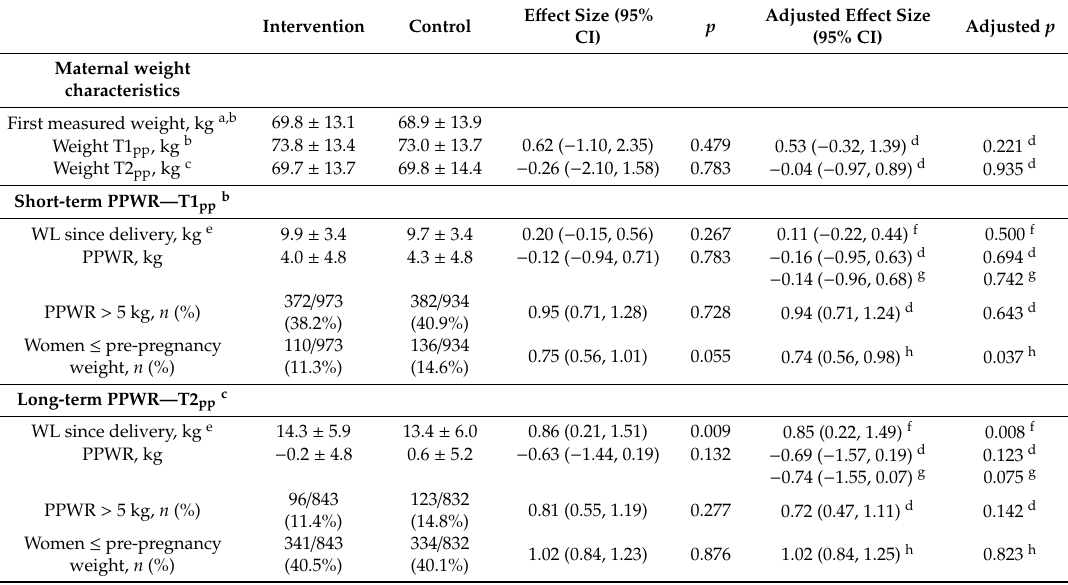
Table 2. Weight outcomes in intervention and control groups.